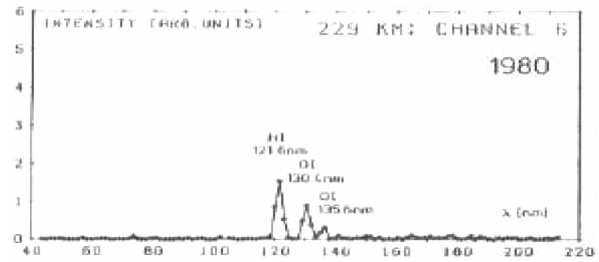
Figure 26. Emission spectrum of an oscillating diffuse aurora on 16 November 1980 over Kiruna, Sweden (Schmidtke et al., 1983; copyright permission granted by Elsevier